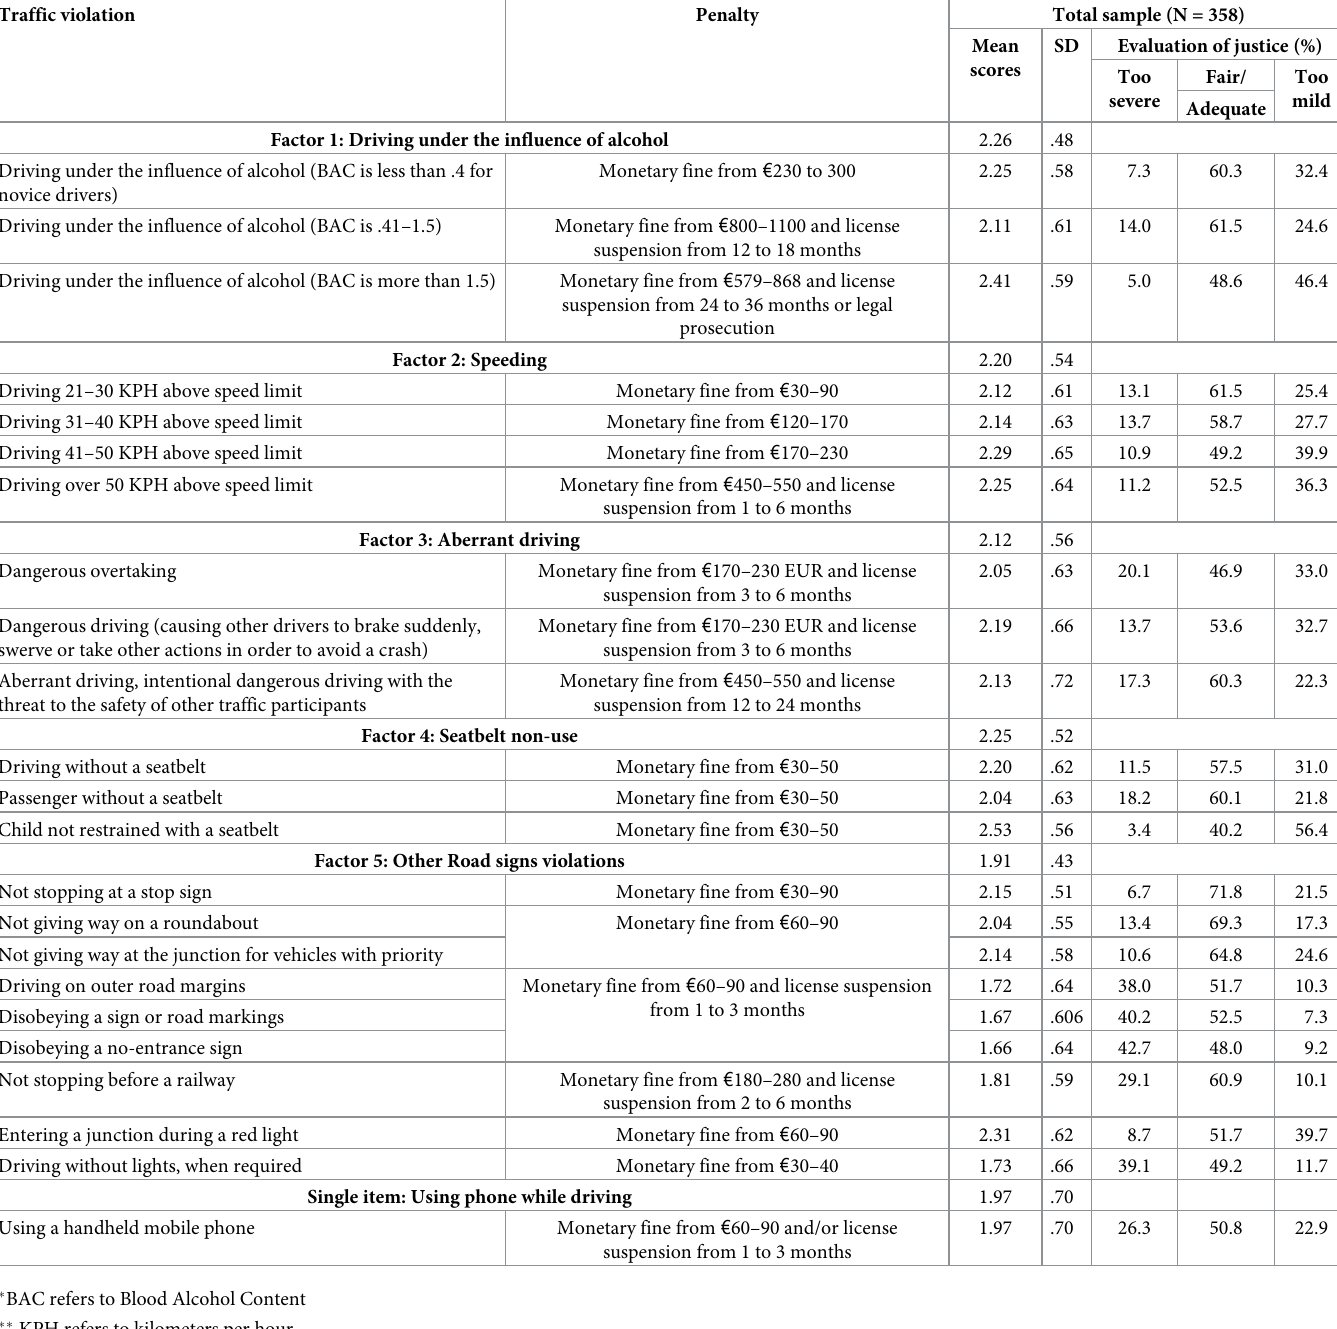
Table 4. The descriptive statistics of penalty’s perceived justice scores in a driver sample (N =